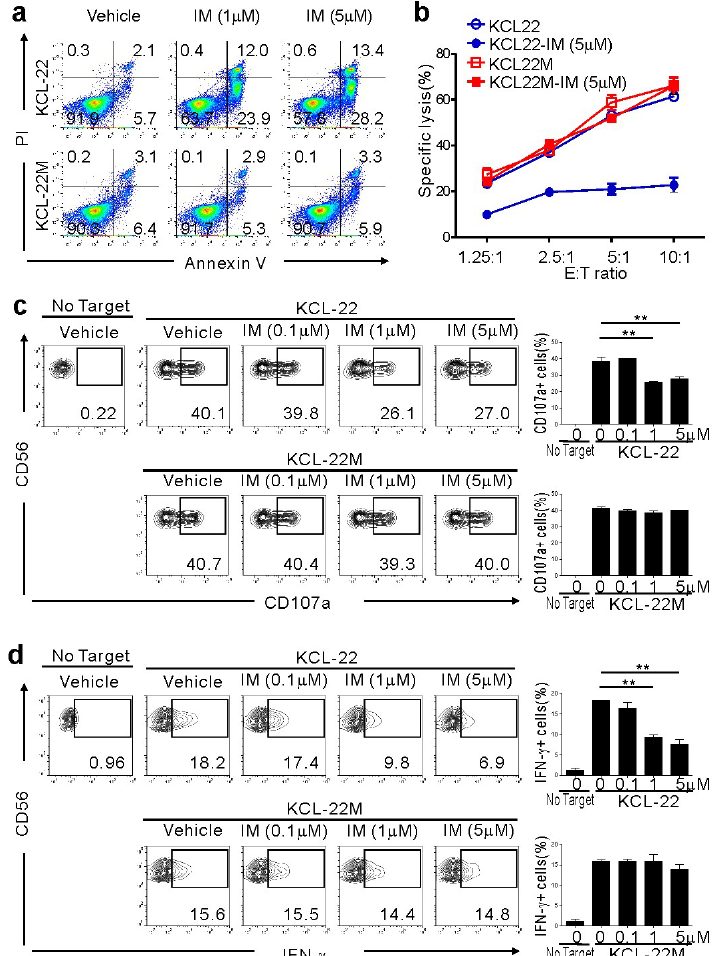
Figure 1. Retained susceptibility of KCL-22M cells, a chronic myeloid leukemia (CML)-blast crisis (BC) cell line harboring BCR-ABL1 T315I, to natural killer (NK) cells following imatinib mesylate (IM) treatment. ( a ) KCL-22 harboring wild-type BCR-ABL1 and KCL-22M cells harboring BCR-ABL1 T315I were treated with IM at the indicated concentrations or vehicle only for 48 h, and apoptosis was measured by annexin V-FITC and PI staining. ( b ) KCL-22 or KCL-22M cells were pretreated with IM (5 µ M) or vehicle only for 48 h, washed, and then, incubated with expanded primary NK cells at the indicated e ff ector to target (E:T) cell ratio. Cytotoxicity against the CML-BC cell line was measured after 2 h with the europium assay. ( c ) KCL-22 or KCL-22M cells were pretreated with IM at the indicated concentrations for 48 h, washed, and then, incubated with expanded primary NK cells for 2 h. Degranulation of NK cells was measured by cell surface expression of CD107a on CD3 − CD56 + NK cells. Representative flow cytometry profiles ( left ) and graph of statistical bar charts ( right ) showing the percent expression of CD107a on NK cells. ( d ) KCL-22 or KCL-22M cells pretreated with IM as in ( c ) were mixed with expanded primary NK cells for intracellular cytokine assay. After 6 h incubation, cells were stained with fluorochrome-conjugated anti-CD3 and anti-CD56 mAbs for surface staining. IFN- γ production was measured in CD3 − CD56 + NK cells after intracellular staining of interferon (IFN)- γ . Representative flow cytometry profiles ( left ) and graph of statistical bar charts ( right ) showing the percent expression of IFN- γ by NK cells. The mean values ± s.d. of three independent experiments are shown. ** p < 0.01 by Student’s t -test.